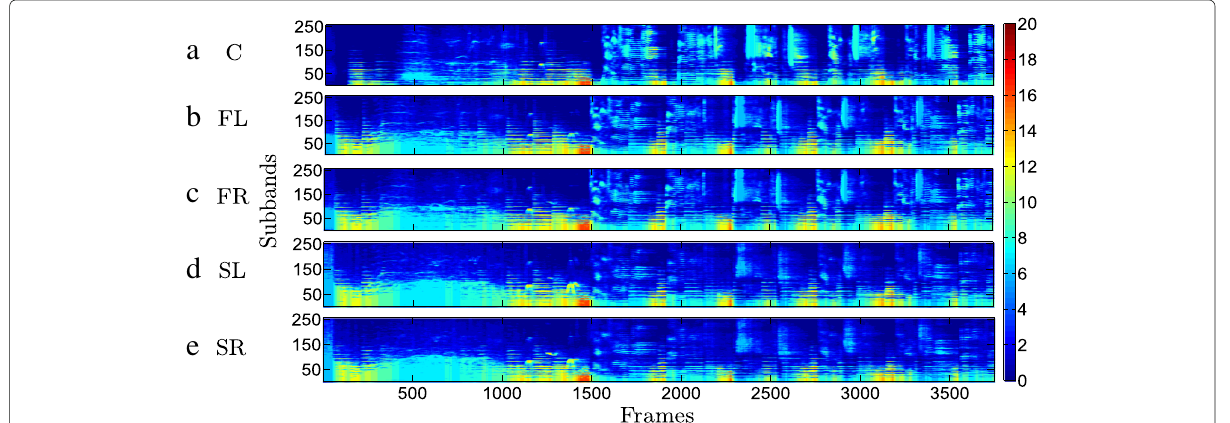
Fig. 13 Number of taps L r ( k , (cid:2)) updated in the different sub-filters in every frame for the ( a ) centre, ( b ) front left, ( c ) front right, ( d ) side left and ( e ) side right channels when using the DEA tap selection scheme for Q = 0.2 for a 30-s segment of a 5-channel concert